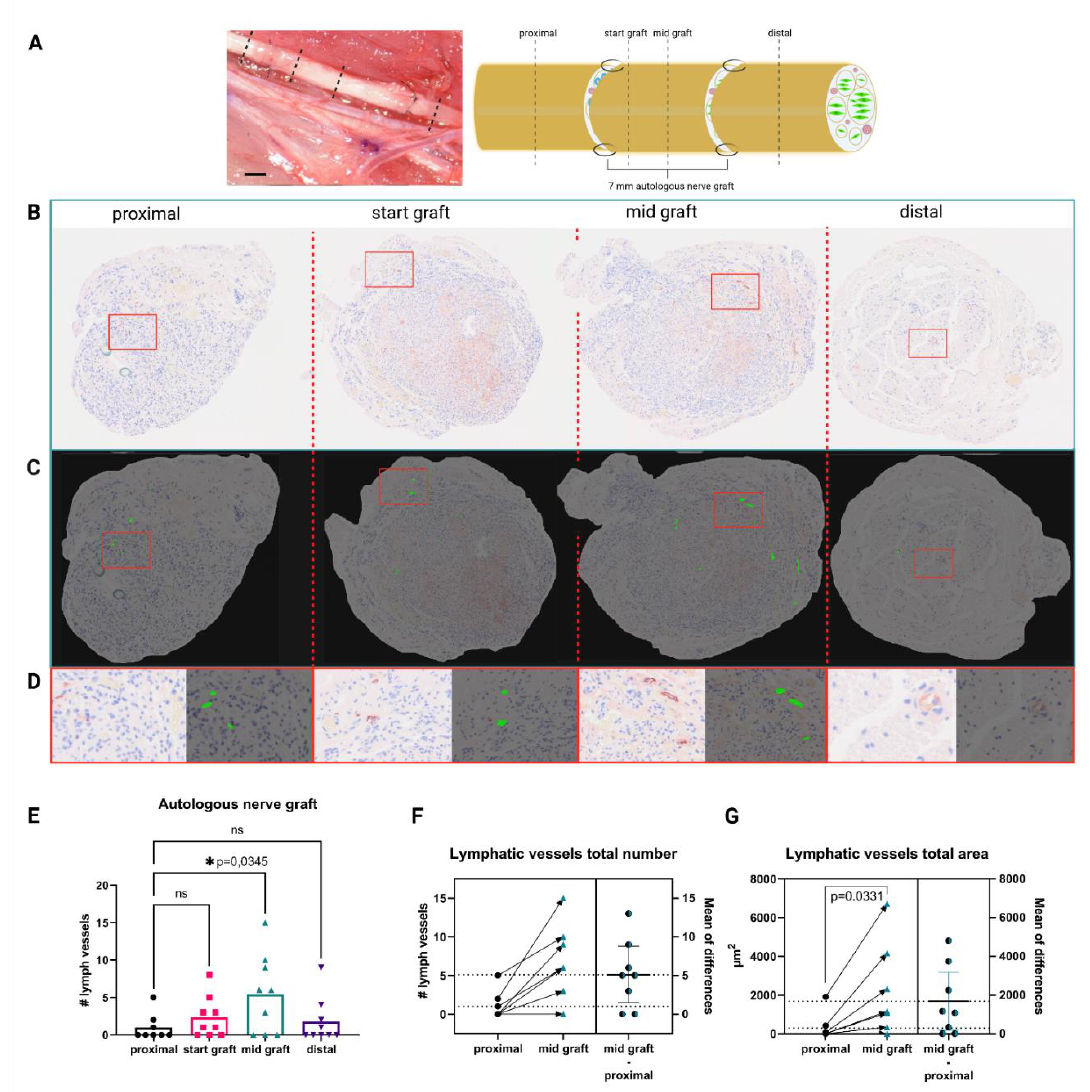
Figure 1. Autologous nerve grafting results in increased intraneural lymphangiogenesis. ( A ) in vivo appearance of the median nerve after autologous nerve grafting and schematic of the repaired me- dian nerve, with histological sections and their respective localization indicated as proximal, start graft, mid graft, and distal. Dotted lines indicate histological cutting planes. Scale bar = 1 mm ( B ) Representative histological cross sections of the rat median nerve, 3 months after autologous nerve grafting stained for podoplanin. From left to right: proximal to the autologous nerve graft, start of the graft, mid-section of the graft, and distal to the graft; red rectangles indicate enlarged regions of interest depicted in ( D ). ( C ) Readout of the automated identification using KML Vision IKOSA deep learning algorithm, lymphatic vessels are highlighted in green, red rectangles indicate enlarged re- gions of interest depicted in ( D ). ( D ) Side-by-side comparison of respective regions of interest within histological pictures with automatically identified lymphatic vessels. ( E ) Quantification of podoplanin+ lymphatic vessels in the histological sections shows a significantly higher number of lymphatic vessels at mid graft level, when compared to the proximal nerve section. ( F ) Comparison of lymphatic vessel number proximal to mid graft in individual nerves shows increases in lymphatic vessel number in almost all samples. The average increase in vessel number from proximal to mid graft was 5; lower dotted line indicates the mean lymphatic vessel number in the proximal segment; whereas, the upper dotted line indicates the mean lymphatic vessel number in the mid graft seg- ment. Arrows indicate changes in nerve segments of the same samples ( n = 8). ( G ) Similar to ( F ), the comparison of the total vessel area also revealed a significant increase from the proximal to the mid graft segment of individual nerves, with an average increase of 1800 µm 2 , dotted lines represent average proximal and mid graft lymphatic vessel area ( n = 8). (ns — not significant, p < 0.05 was